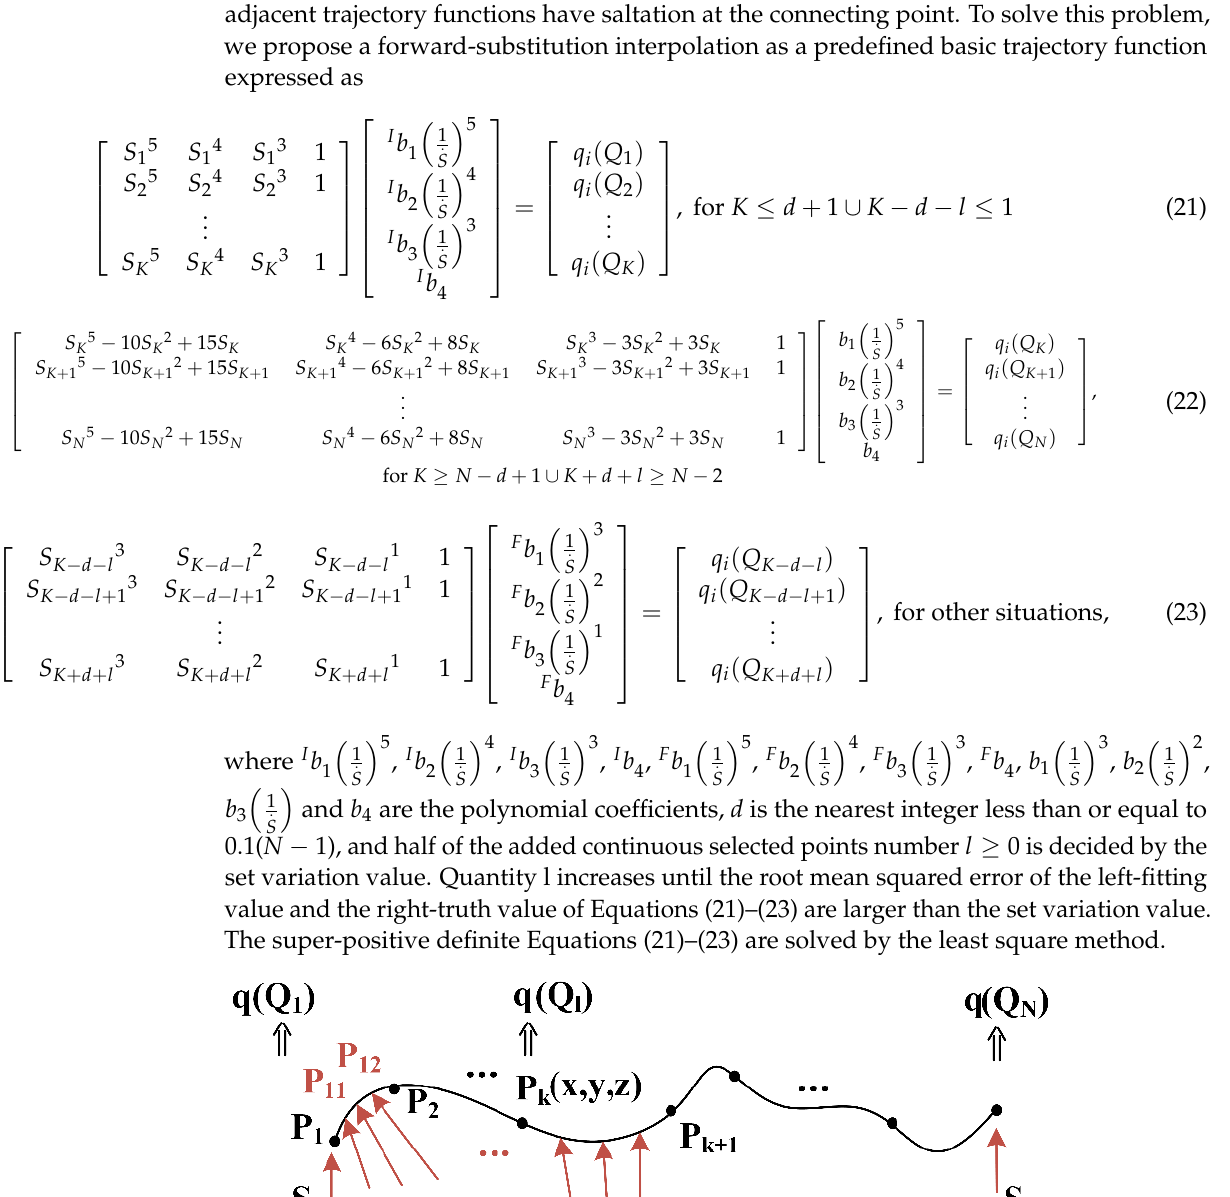
( s ) and q (cid:48)(cid:48) ( s ) are substituted into the j j i i